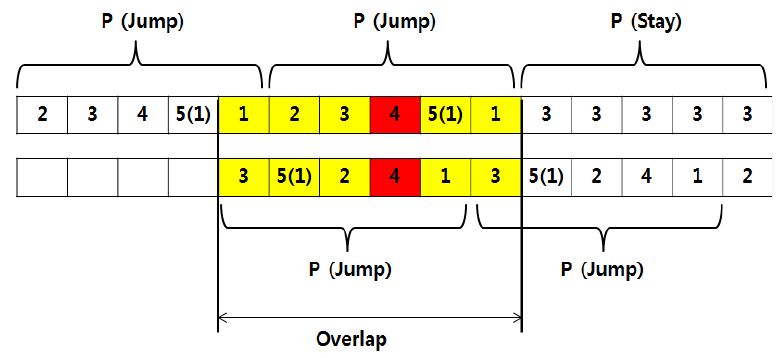
Figure 1. An example of symmetric JS